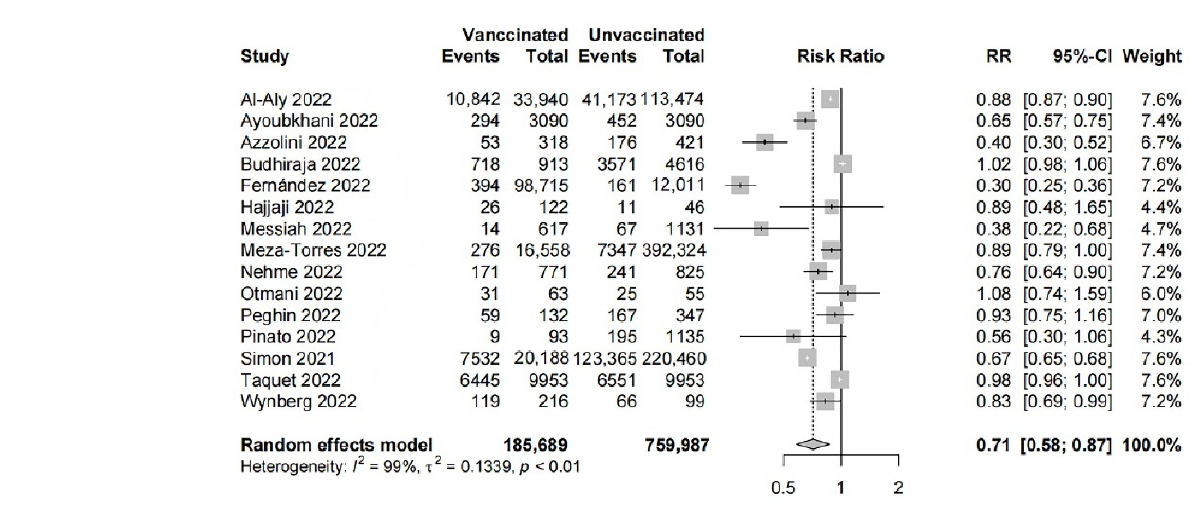
Figure 2. Forest plot of the effect of vaccination on long COVID [7,15,16,21,23–29,31,33–35].